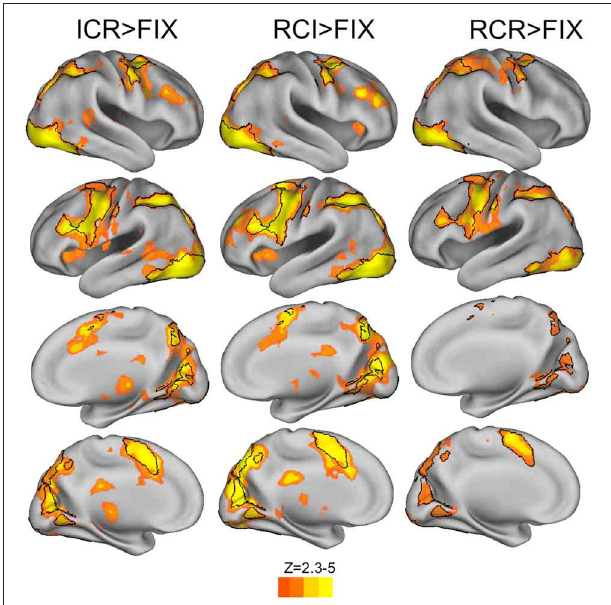
FIGURE 5 | BOLD responses to selective vs. global context conditions (red-yellow) and common areas of recruitment (black outlines). Contrasts of RCI and ICR vs. RCR revealed reliable BOLD response across frontal, parietal, and occipital cortex (voxelwise z > 2 . 3, corrected to p < 0 . 05 via GRF). The reverse contrasts of RCR > ICR and RCR > RCI, and the direct contrasts of ICR with RCI, failed to reach